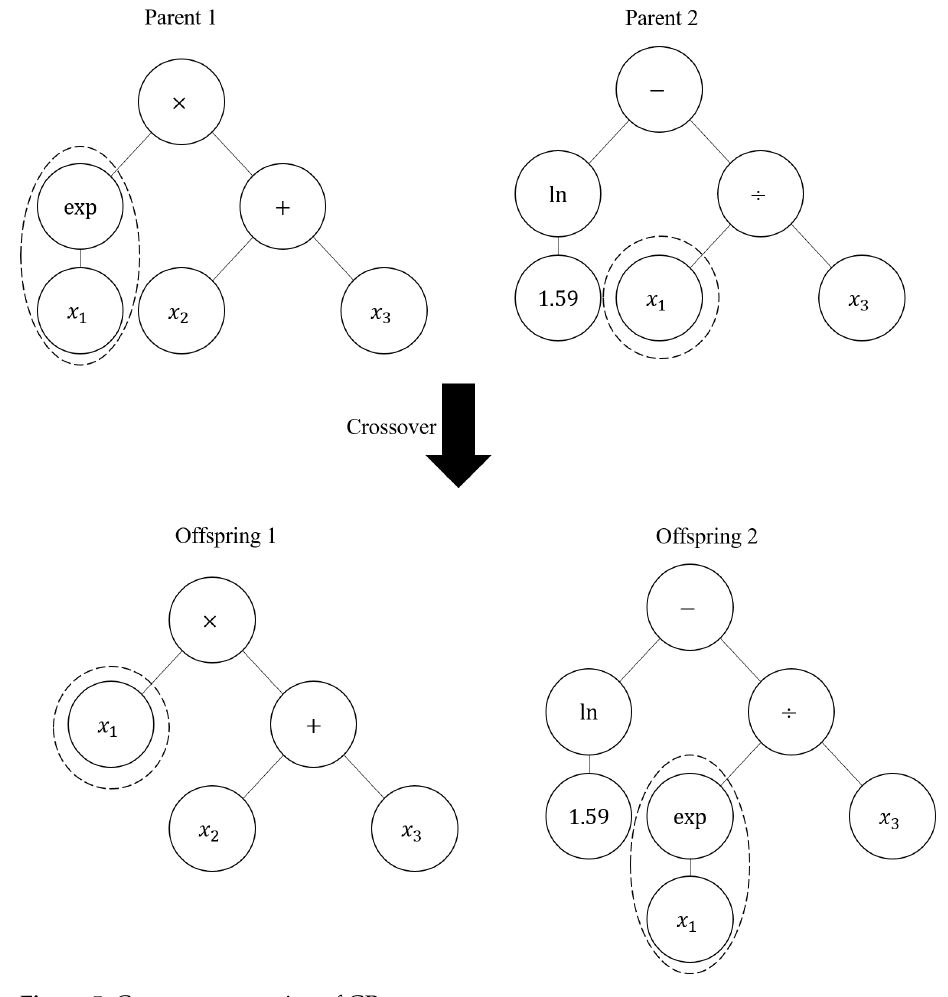
Figure 5. Crossover operation of GP.